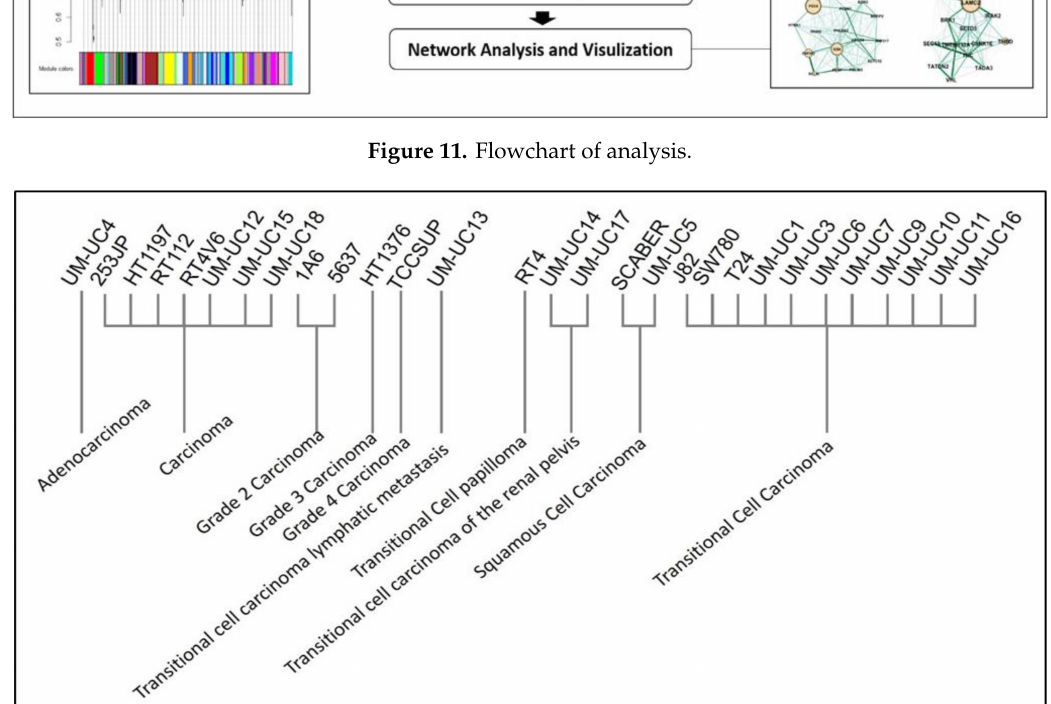
Figure 12. Diseases of bladder cancer cell lines 4.2. Data